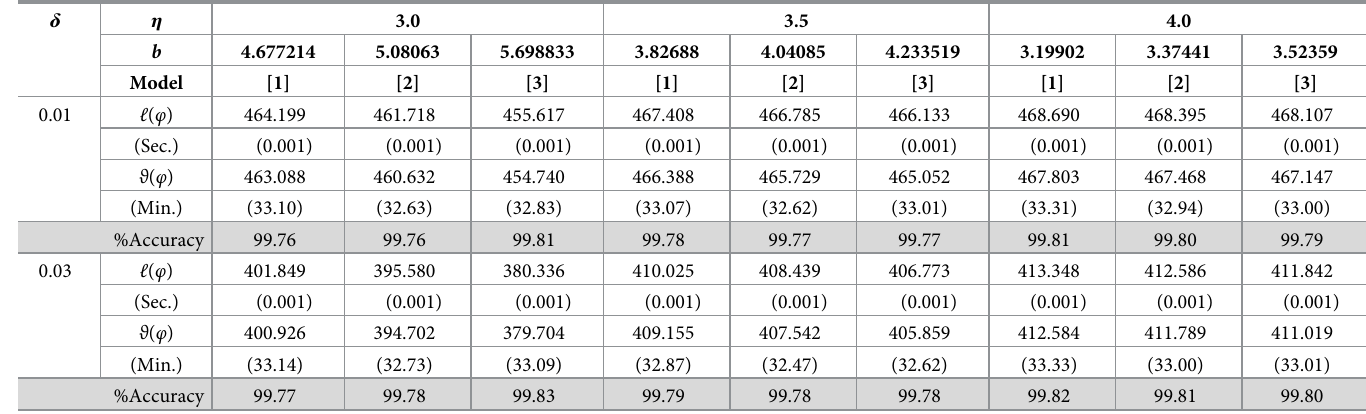
Table 4. Comparison of the ARL 1 values obtained using the analytical and numerical ARL methods for long-memory SARFIMAX( P , D , Q , r ) nential white noise on a CUSUM control chart for ARL 0 = 500 with F 1 = 0.1, F 2 = 0.2, Θ 1 = 0.1, and ω 1 =